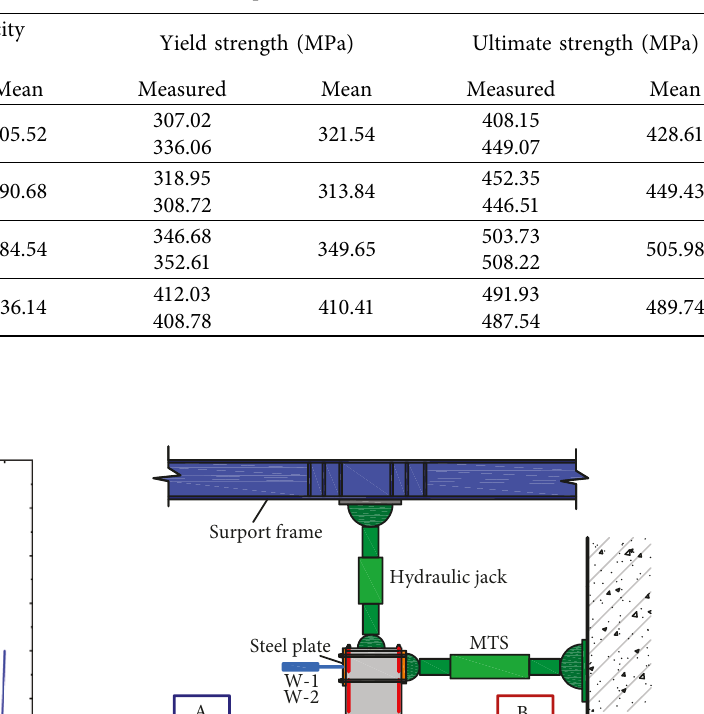
Table 4: Performance test results of steel plates.